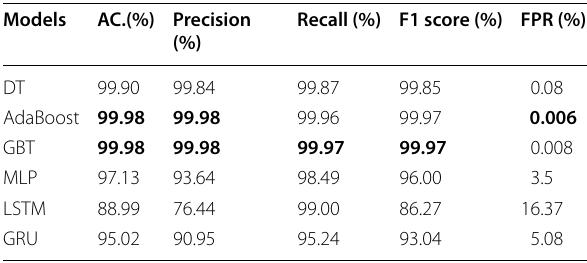
Table 6 Result of the models with reduced features (20) for UNSW-NB 15 dataset